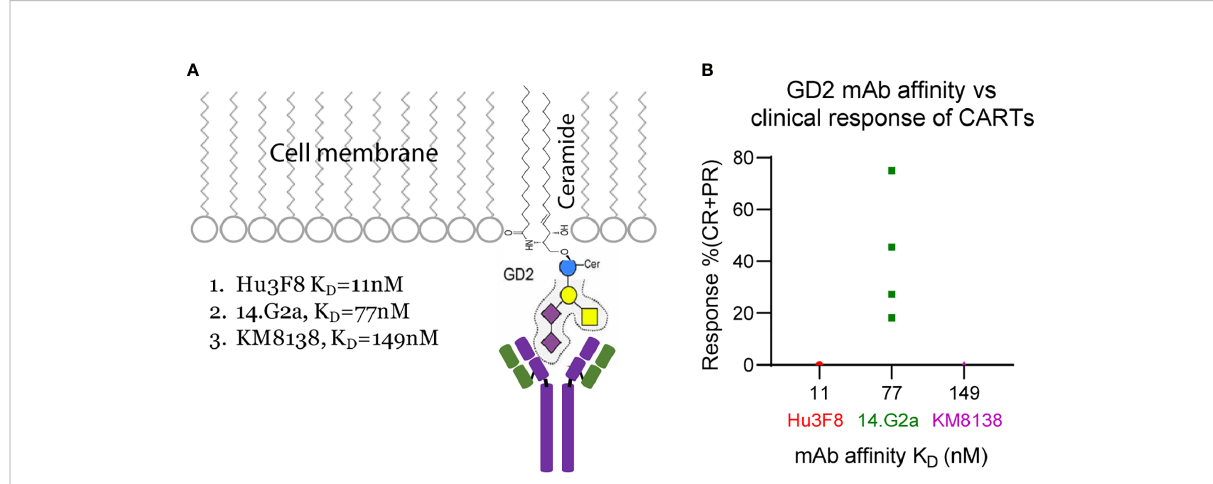
FIGURE 2 GD2 sugar moiety (A) and correlation of anti-GD2 mAb af fi nity with clinical ef fi cacy (B) of the GD2